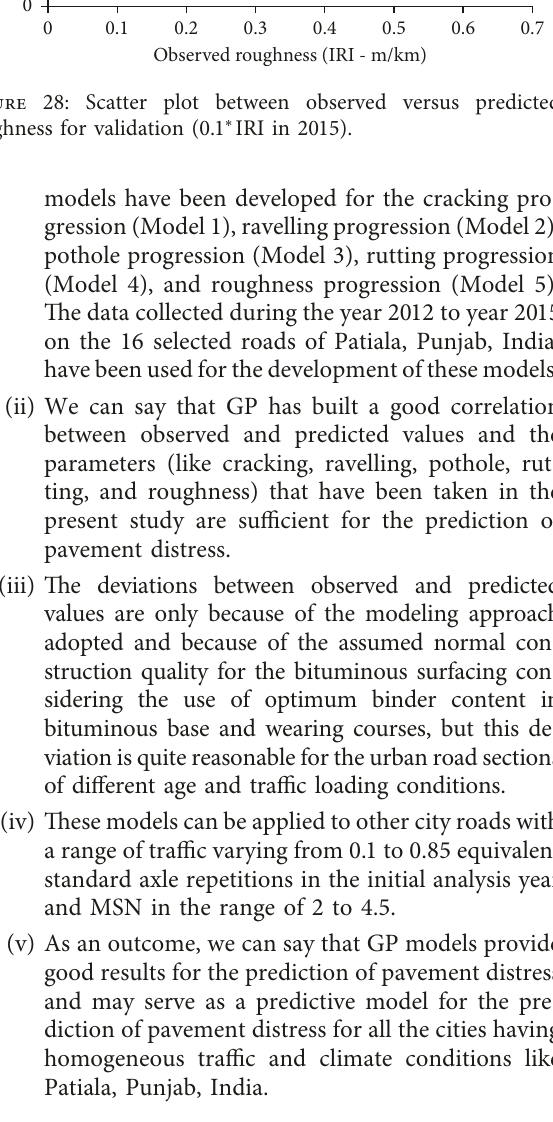
Figure 28: Scatter plot between observed versus predicted roughness for validation (0.1